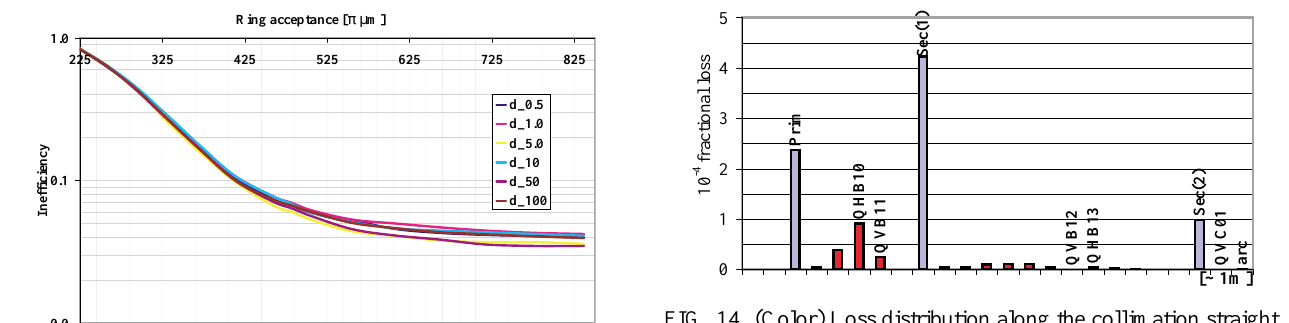
FIG. 14. (Color) Loss distribution along the collimation straight section. Each bin is approximately 1 m long. Losses in the collimators correspond to controlled loss and are plotted in blue. The quadrupole QHV10 right after the primary scraper receives an unacceptably high loss. As a result, the design of the primary scraper has been